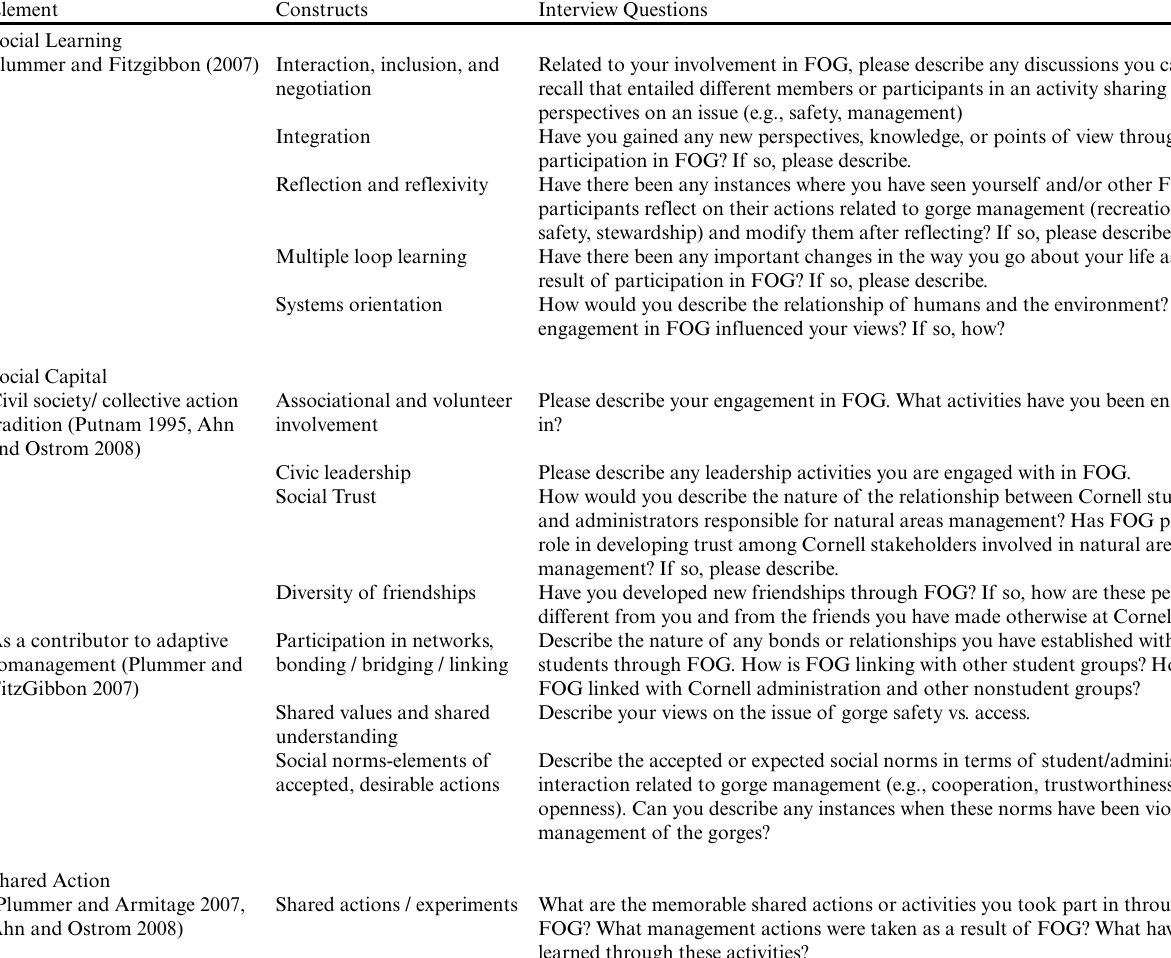
Table 1 . Social capital, social learning, and shared action: constructs and semistructured interview questions. FOG = Cornell’s Friends of the Gorge student